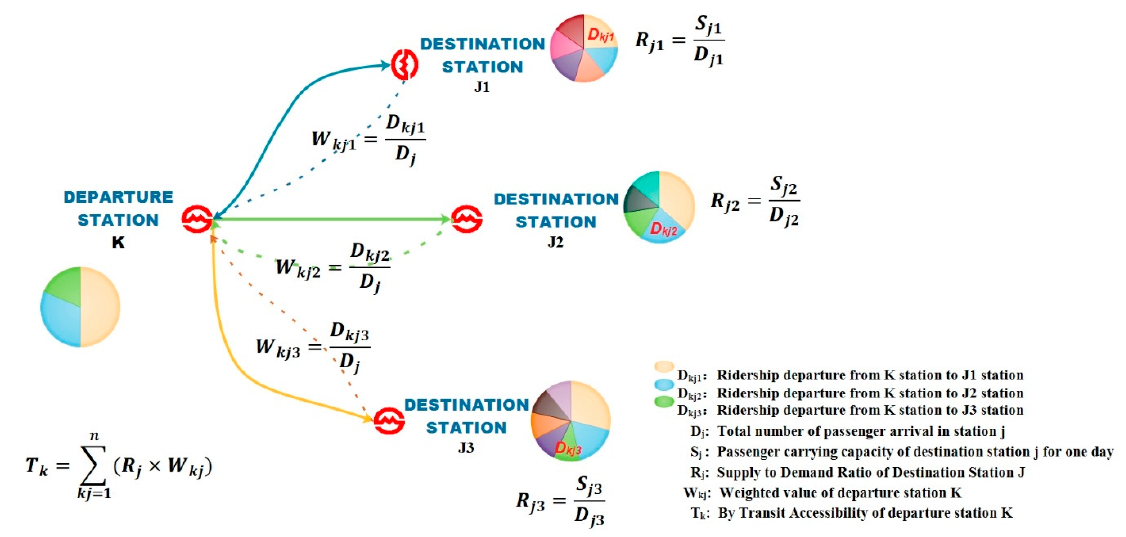
Figure 2. The method used to estimate the BTA at the departure station.